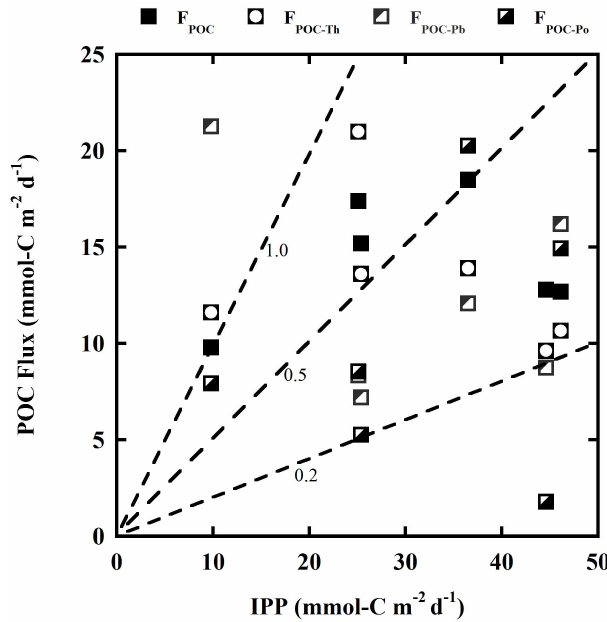
Fig. 9. Correlation of F POC , F POC − Th 0 , F POC − Pb 0 , and F POC − Po 0 with integrated primary productivity (IPP). Export ratios of 0.2 and 0.5 are shown by dashed